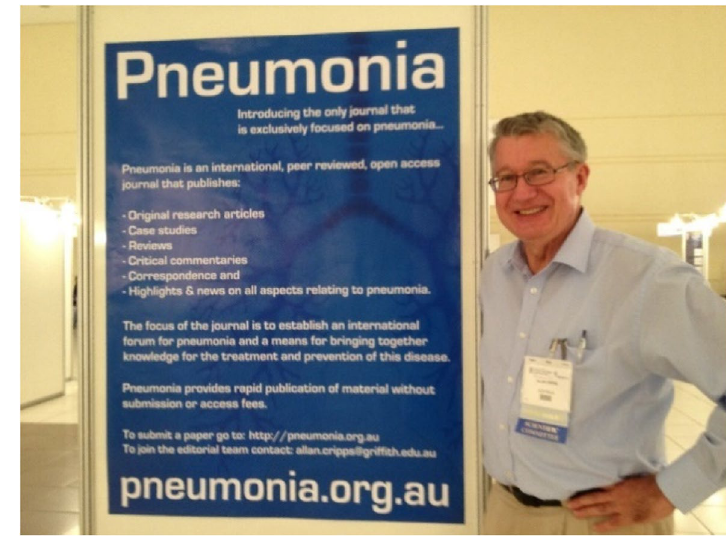
Fig. 1 Founding editor of Pneumonia, Alan Cripps, announcing the birth of the journal on March 11, 2012